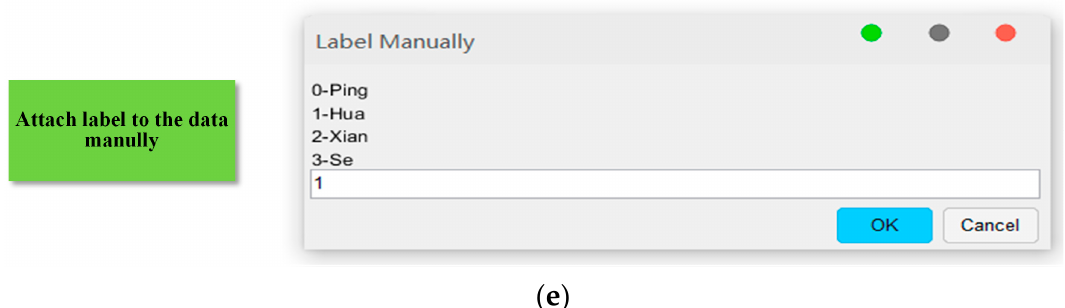
Figure 3. Data collection and preprocessing. (a) roughly select a segment; (b) remove high frequency noise; (c) remove baseline wander; (d) select an appropriate area as a piece of data; (e) normalize, label, and store the data.